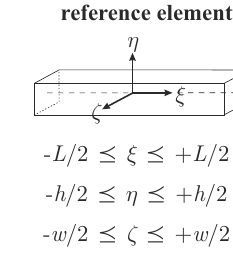
a non-collinear | r 0 |